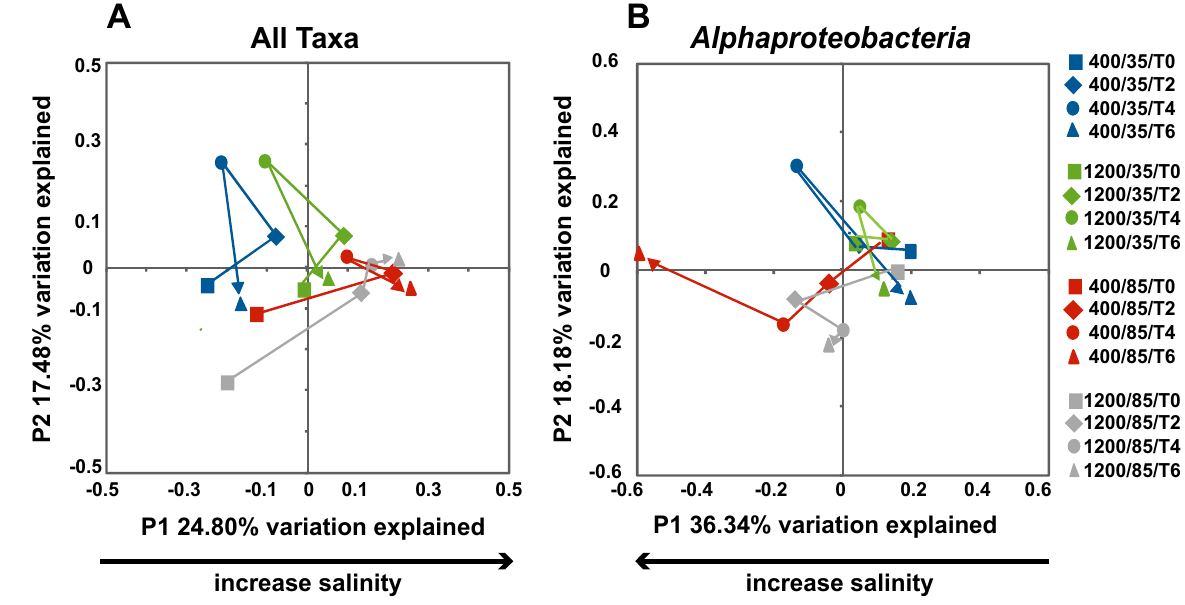
Figure 5. Principal coordinate analysis of bacterial 16S rRNA gene libraries for the 16 lithifying mat libraries using Fast UniFrac. (A) Analysis of all sequencing reads recovered from the microbialites. Plot of the first two principal coordinate axes, which represent 24.80% (P1) and 17.48% (P2) of the variations detected between treatments; (B) Plot of first two principal coordinate axes generated from Fast UniFrac analysis of only the Alphaproteobacteria reads. Axes represent 36.34% (P1) and 18.18% (P2) of the variation between mat samples. Symbols represent bacterial sequences from each mat library with squares representing samples taken at time 0 months (T0); diamonds, 2 months (T2); circles, 4 months (T4); and triangles, 6 months (T6). Color of symbols reflect the , 35‰ salinity); green (1200 ppmv CO , environmental treatment: blue (400 ppmv CO 2 2 35‰); red (400 ppmv CO , 85‰); and grey (1200 ppmv CO , 85‰). Colored arrows 2 2 within indicate changes in community structure over